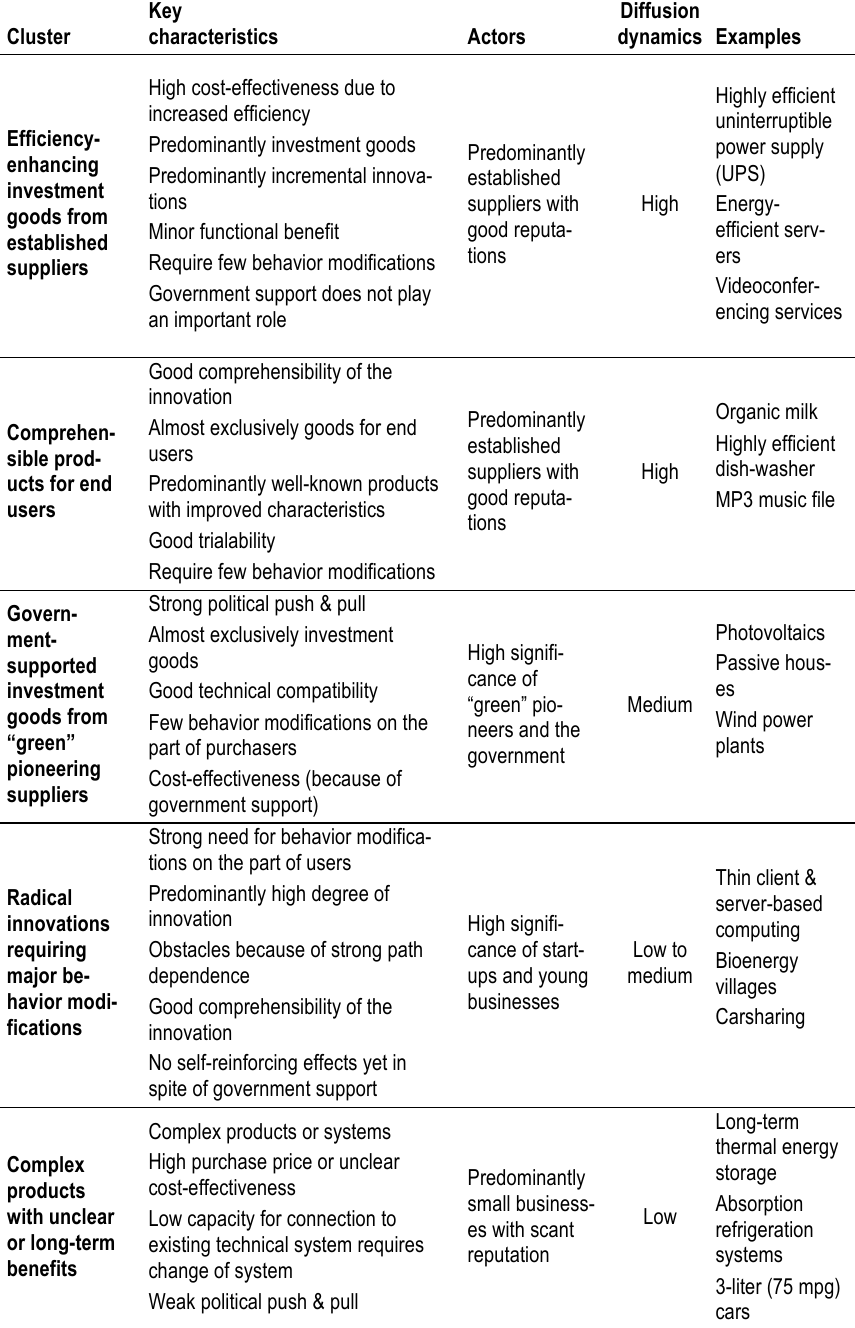
Table 7. Characterization of clusters of diffusion of sustainable innovation Key Cluster characteristics Actors